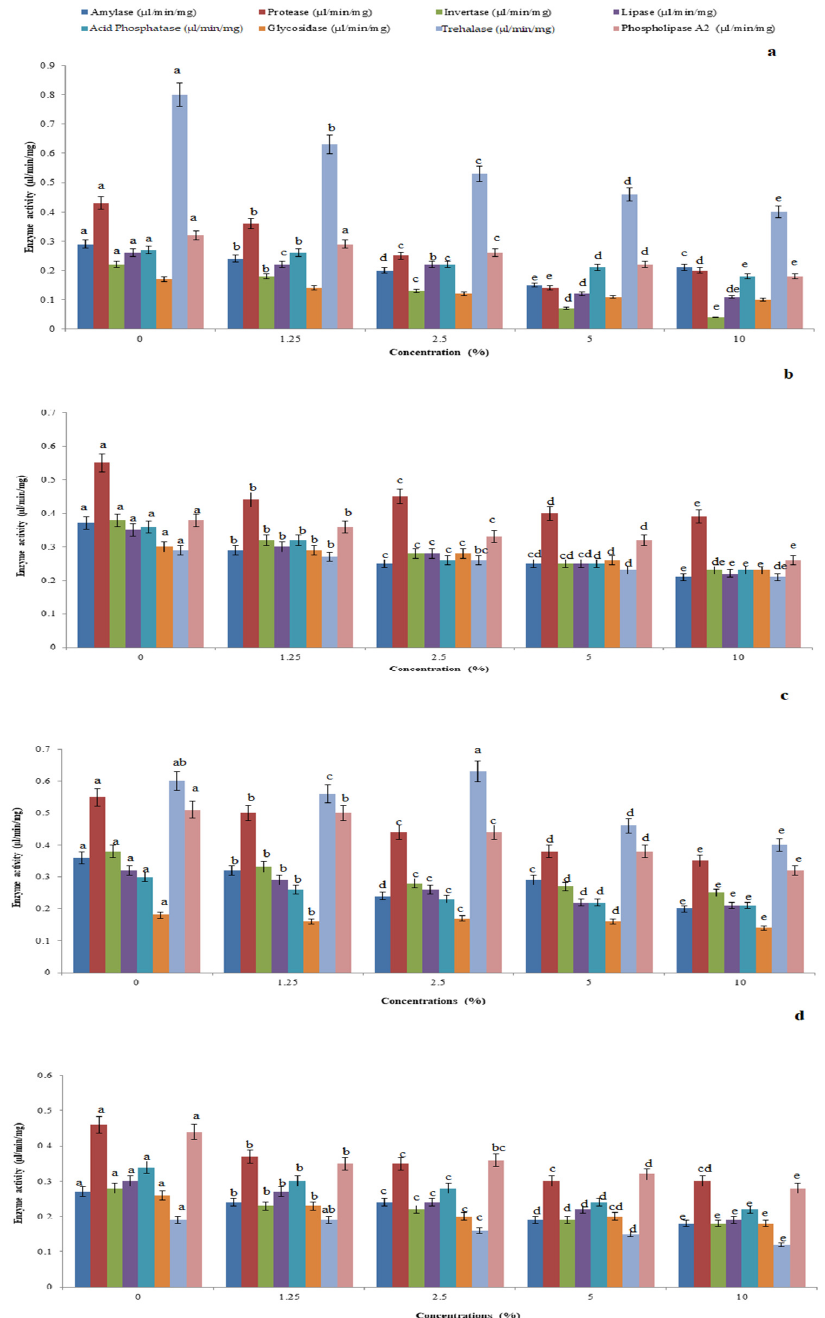
Figure 2. Whole insect body hydrolytic enzymes amylase, protease, invertase, lipase, acid phosphatase, glycosidase, trehalase, and phospholipase A 2 levels of P. solenopsis exposed to P. glabura -AgNPs ( a ), I. carnea- AgNPs ( b ), A. squamosa- AgNPs ( c ), and J. adathoda- AgNPs ( d ) at different concentrations. Different letters (among the same concentration for each enzyme separately) above bars indicate significantly different means according to Tukey’s test ( p < 0.05). Bars indicate the standard error (SE)